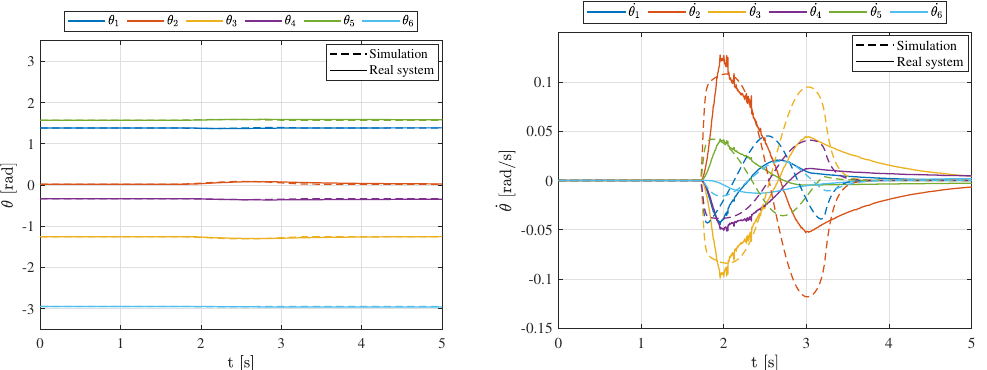
Figure 15. Test case 3, Mode I. Joint rotations ( left ) and speeds ( right